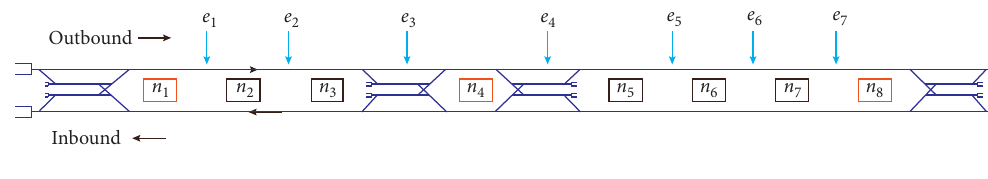
Figure 1: An urban rail transit corridor.